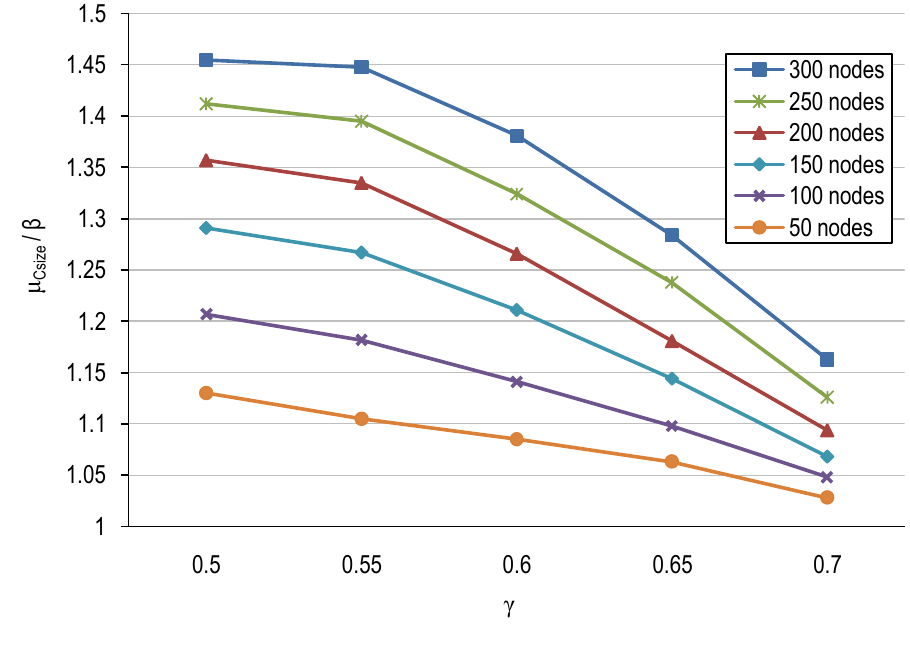
/β for several node densities and overlapping scales, Csize